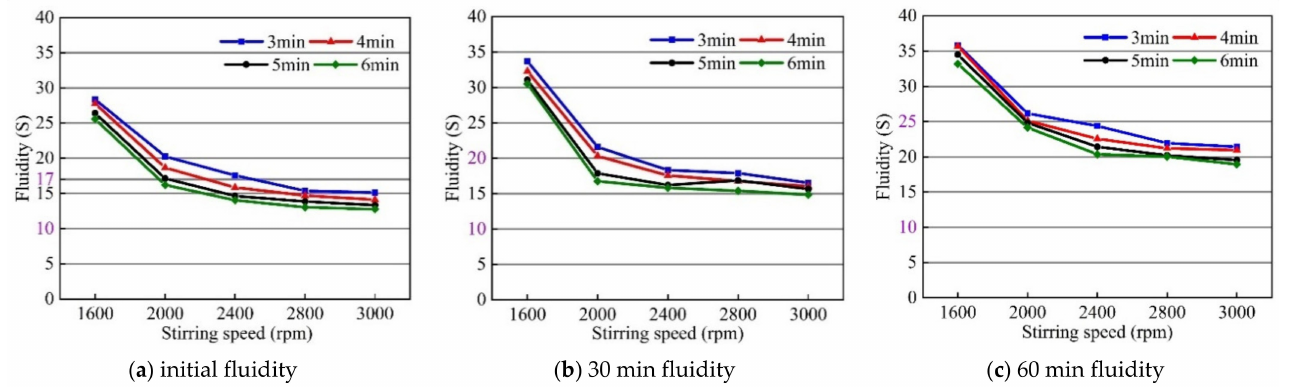
Figure 9. The fluidity of crumb rubber grouts under different stirring rates and stirring